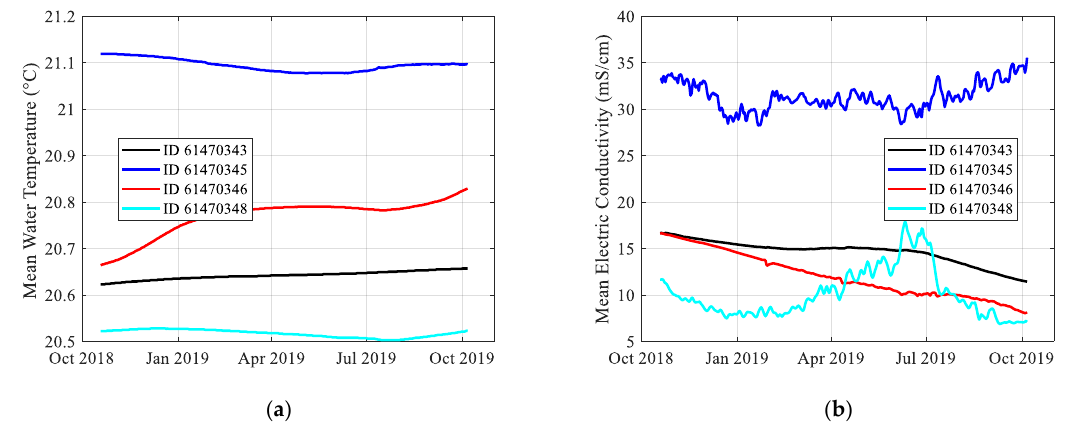
Figure 4. ( a ) Temperature time series of groundwater wells; ( b ) electric conductivity time series of groundwater wells; IDs of wells according to Figure 2; data provided by [53].